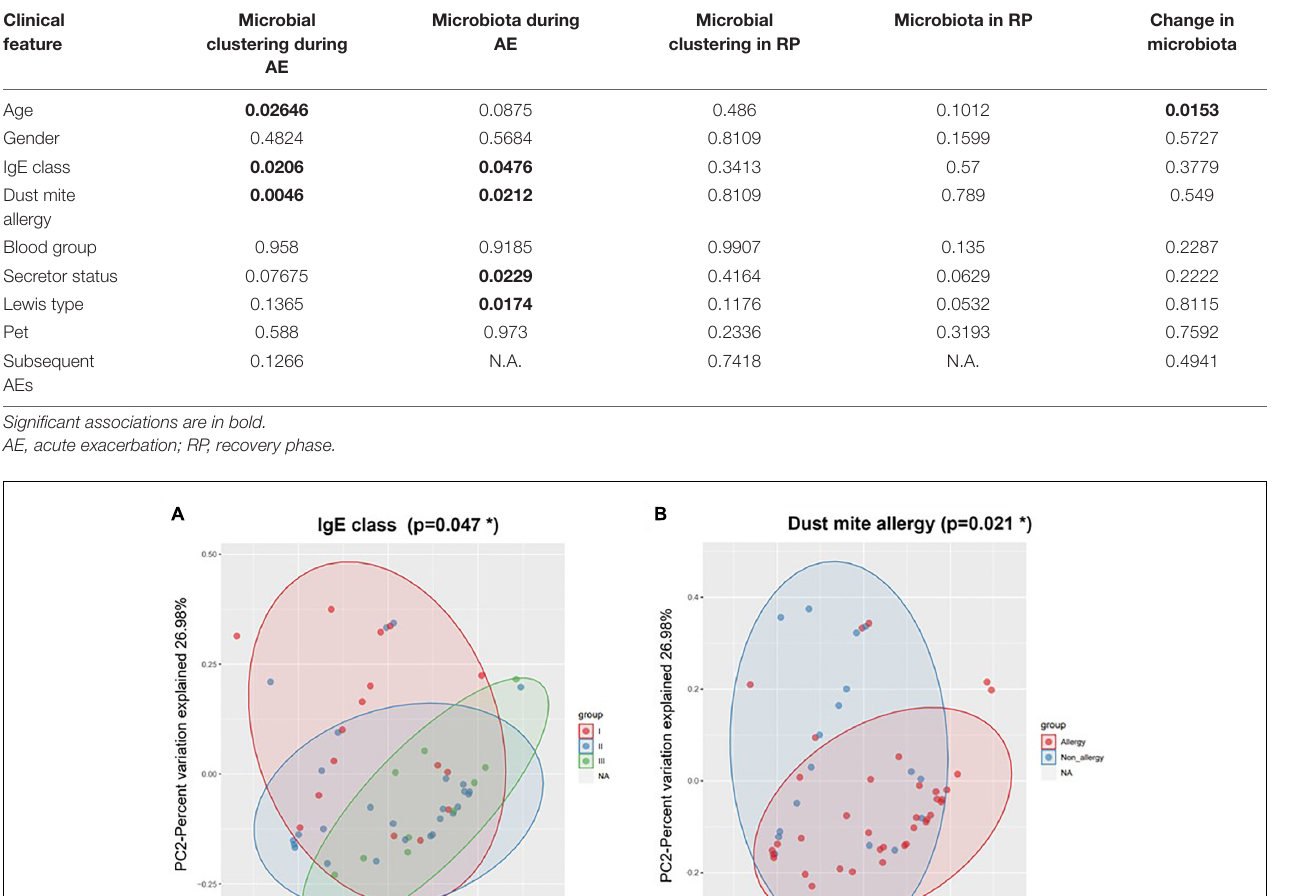
TABLE 1 | Significance of association between clinical features and microbial clustering or microbiota for nasal samples.